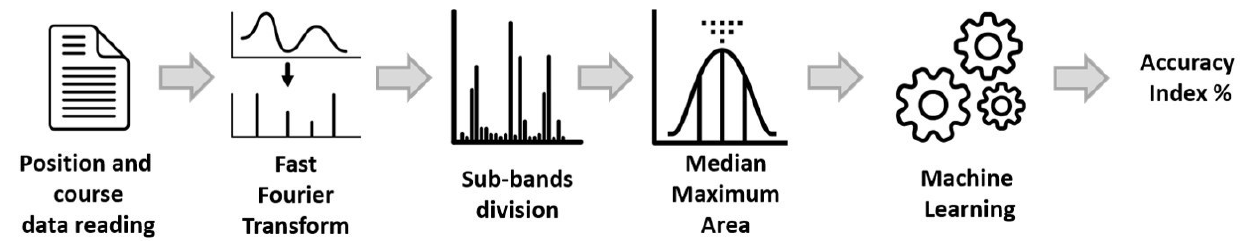
Figure 3. ML approach to classify vessel’s trips (Source: [39]). Reprinted with permission from [39]. 2020